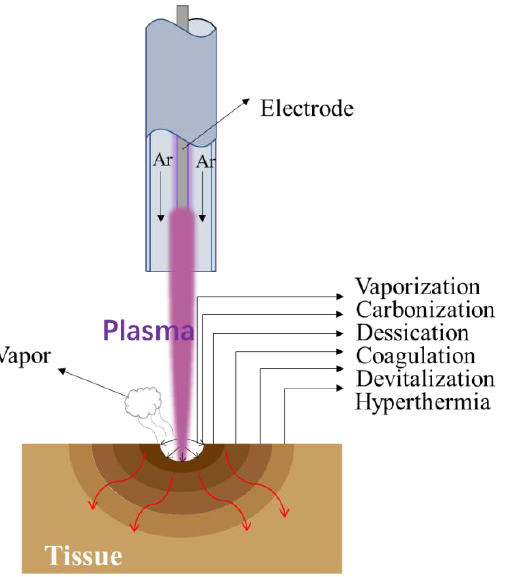
Figure 6. The schematic diagram of the thermal effect of the plasma scalpel.